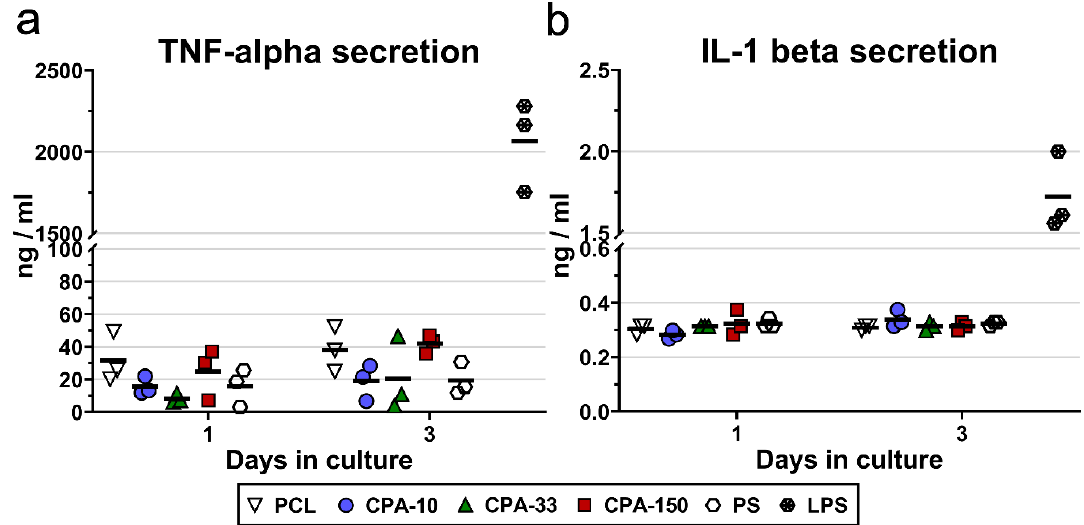
Figure 7. Secretion of ( a ) TNF-alpha and ( b ) IL-1-beta into the culture media by RAW 264.7 cells cultured on amine-PP-coated PCL NFs, deposited at the average RF power ( P av ) of 10, 33, and 150 W (labelled as CPA-10, CPA-33, and CPA-150, respectively), evaluated within 3 days of cultivation. The dots represent individual biological samples. Each dot depicts the arithmetic mean calculated from three pipetting replicates per biological sample. The bold central lines show the arithmetic mean of biological samples. LPS—a positive control of TNF-alpha and IL-1-beta secretion induced by incubation of RAW 264.7 cells with lipopolysaccharide (10 μ g/mL for 24 h).